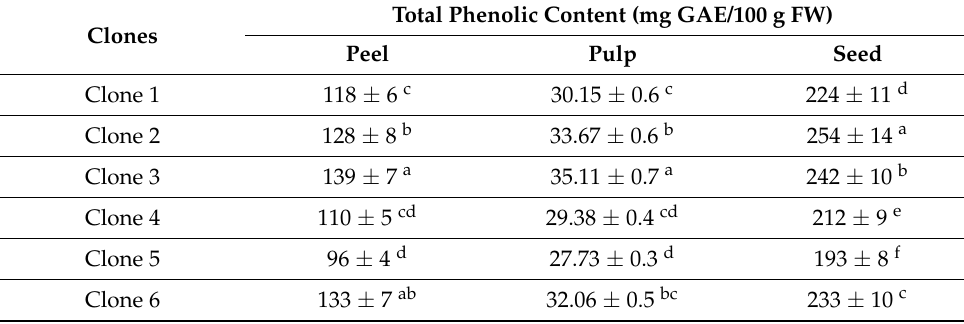
Table 2. Total phenolic content of six ‘Köhnü’ grape clones. Clones